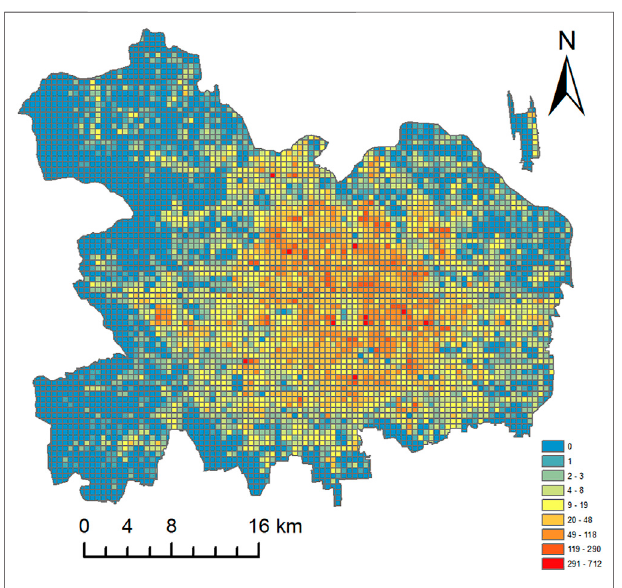
FIGURE 4 | POI content in fi shing nets in 2013.